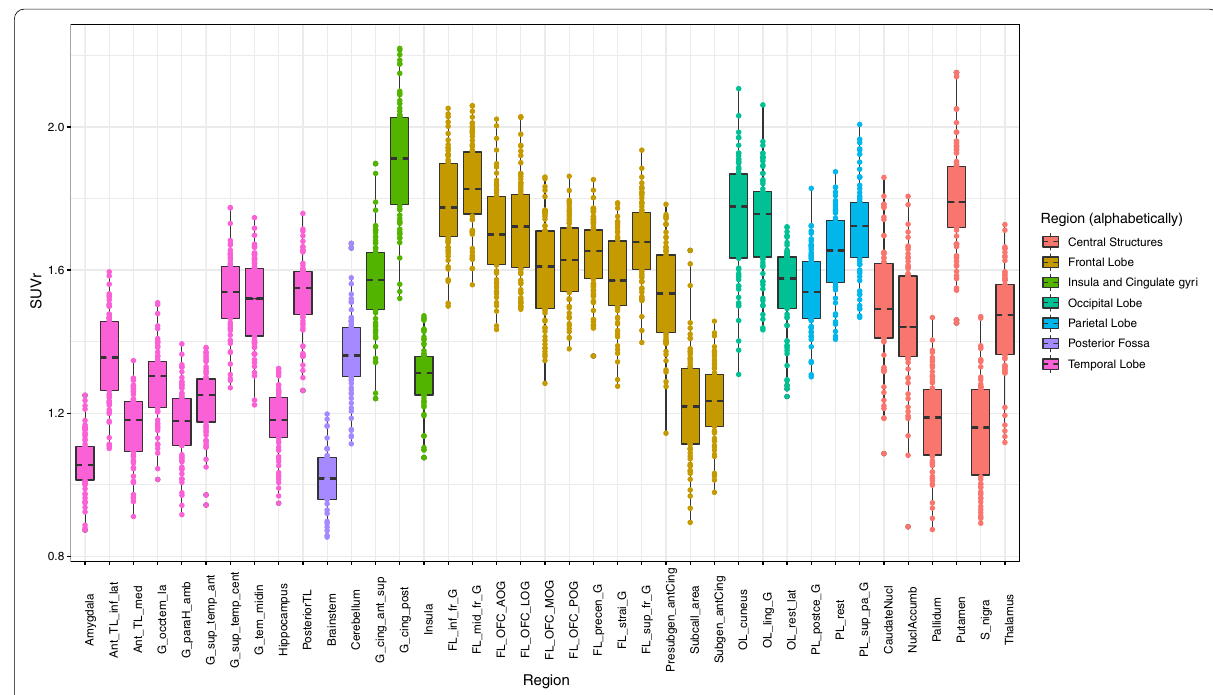
Fig. 4 Boxplot pf regional activity normalized by mean activity in ICV mask (SPM) for all subjects in the database. Centre lines correspond to medians, boxes to interquartile ranges, and whiskers to robust ranges. Outliers are represented as dots